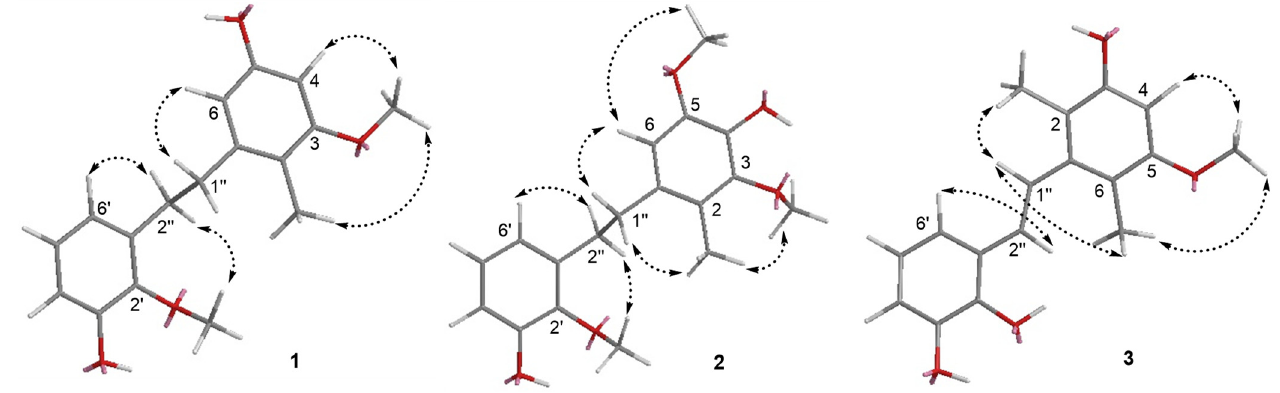
Figure 4. Key ROESY correlations (arrows) of compound 1 – 3 .